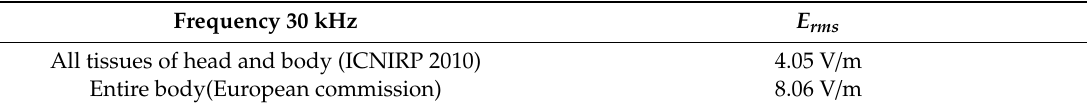
Table 3. Basic restrictions for electrical induced field E .